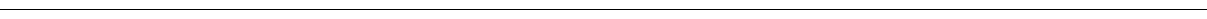
Fig. 2 MiR-31 promotes cell proliferation and concomitantly represses differentiation of mammary epithelium. a Whole mount staining of K5-rtTA and DTG mammary glands at 12 weeks of age. Arrows, DTG mammary ductal ends with three or more TEB-like structures. Scale bar, 0.2 mm. b H&E staining of K5- rtTA and DTG mammary ducts and quanti fi cation of cell layers of mammary ductal epithelium. Scale bar, 25 μ m. c H&E staining of K5-rtTA and DTG mammary TEBs. Scale bar, 25 μ m. d Immuno fl uorescence for Ki67 in K5-rtTA and DTG mammary glands and quanti fi cation of Ki67 + cells in basal